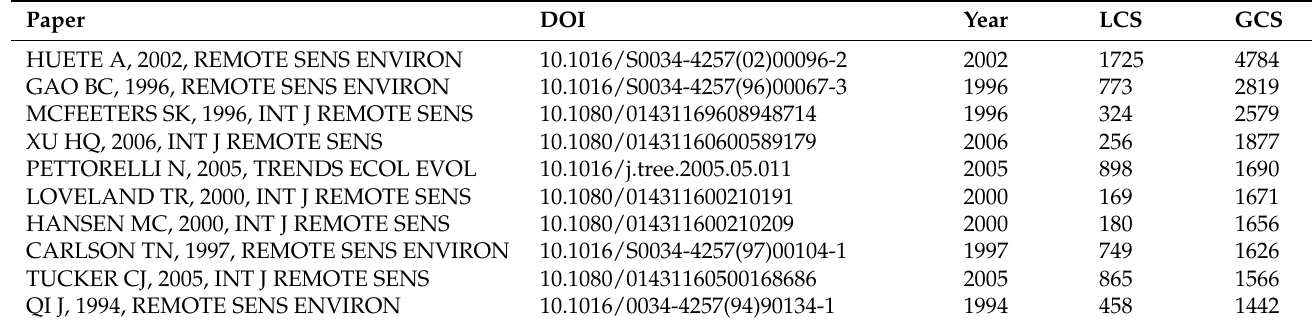
Table 7. Top ten papers according to the global citation